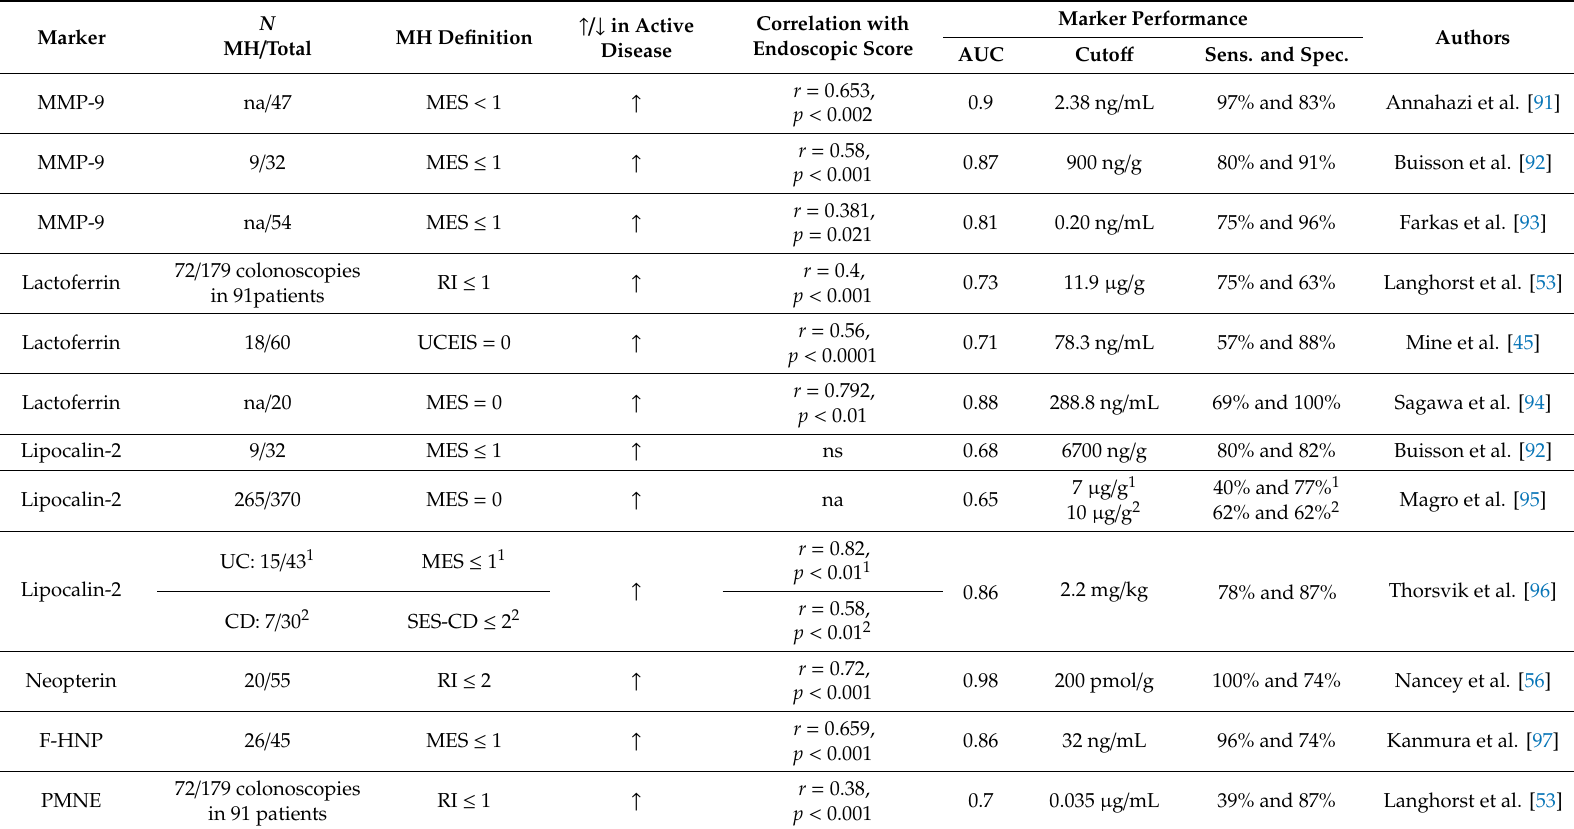
Table 4. Diagnostic performance of other fecal markers in MH detection for ulcerative